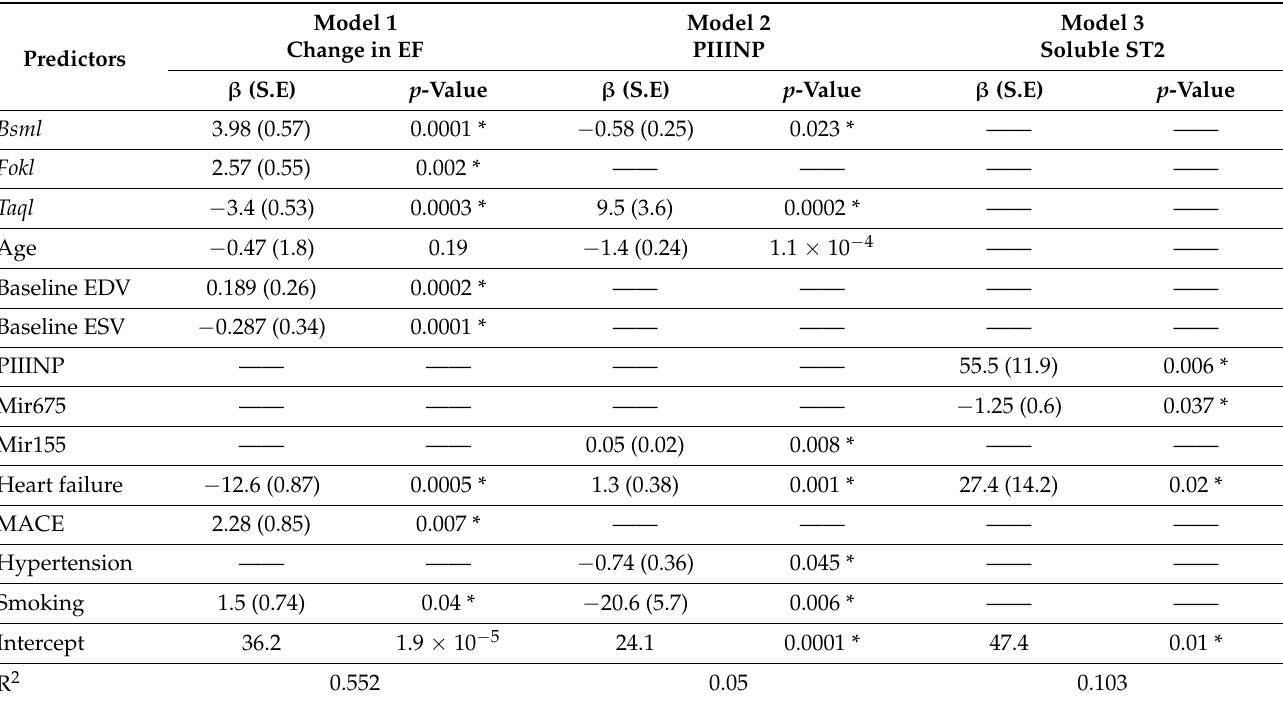
Table 11. Genetic and clinical predictors of ejection fraction and cardiac fibrosis markers.